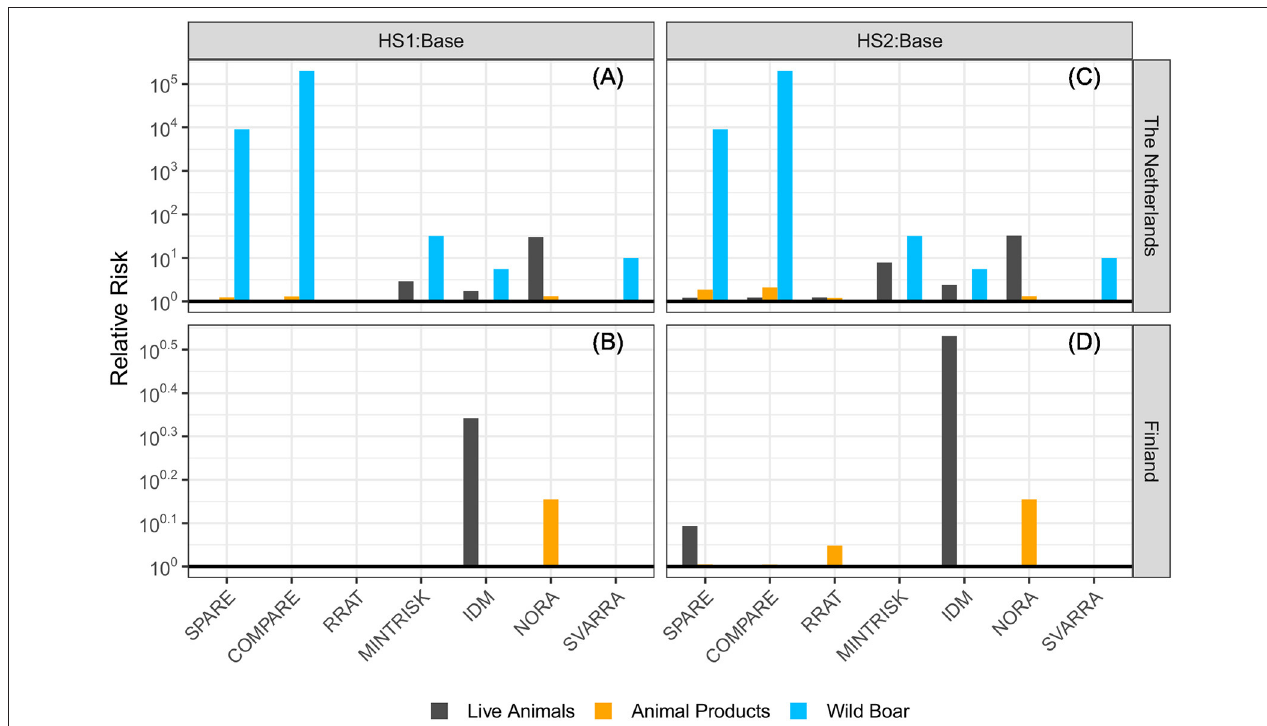
FIGURE 4 | Relative risk of introducing ASF into (A) the Netherlands and (B) Finland in the hypothetical scenario with ASF reported in wild boar in Germany (HS1) and (C) the Netherlands and (D) Finland with ASF reported in wild boar and domestic pigs in Germany (HS2) compared to the baseline scenario (2017 situation). A relative risk of 1 (bold line) denotes no differences in risks among the scenarios. Please note the different scales used on the